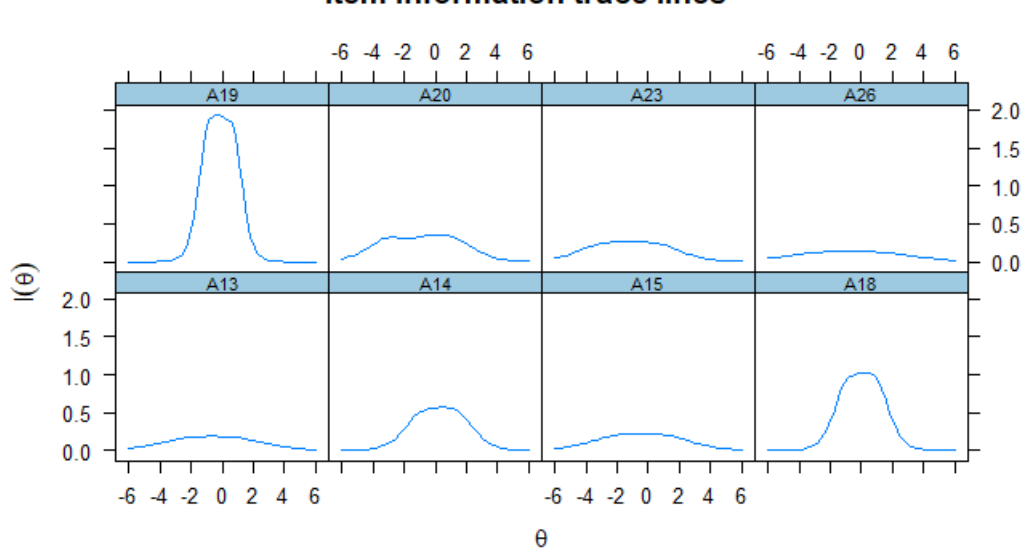
Figure 1. Total information curves of items (TICs) of the Religious Needs component.